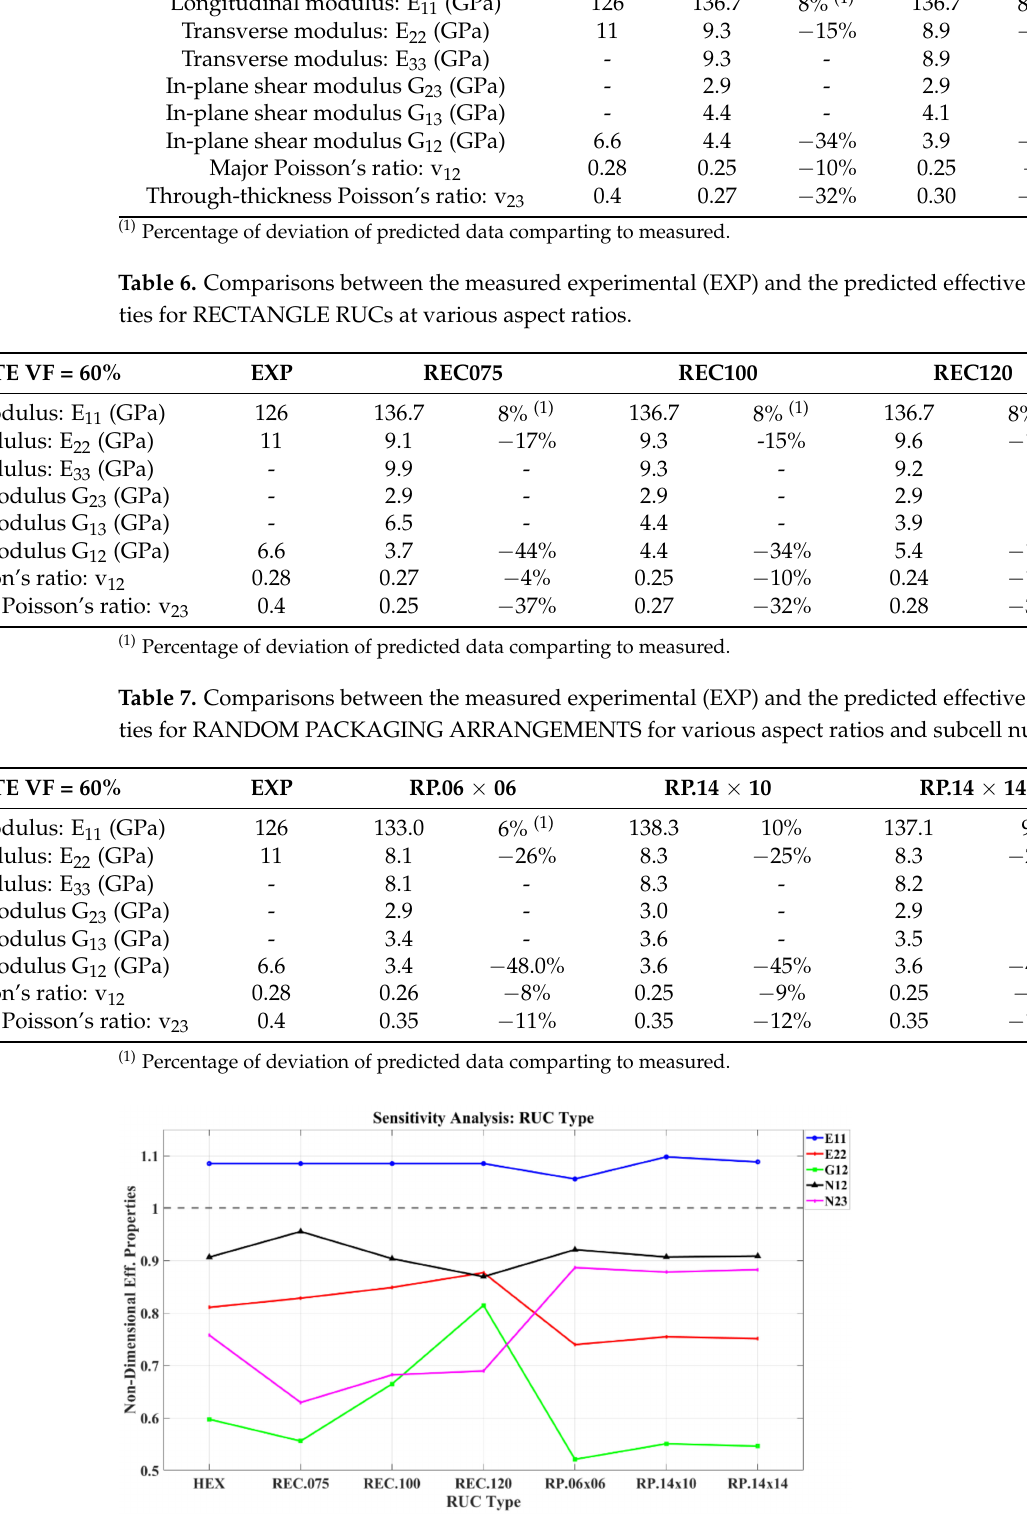
Figure 7. Nondimensional predicted effective properties for various RUCs. A value of 1 corresponds to measured experimental